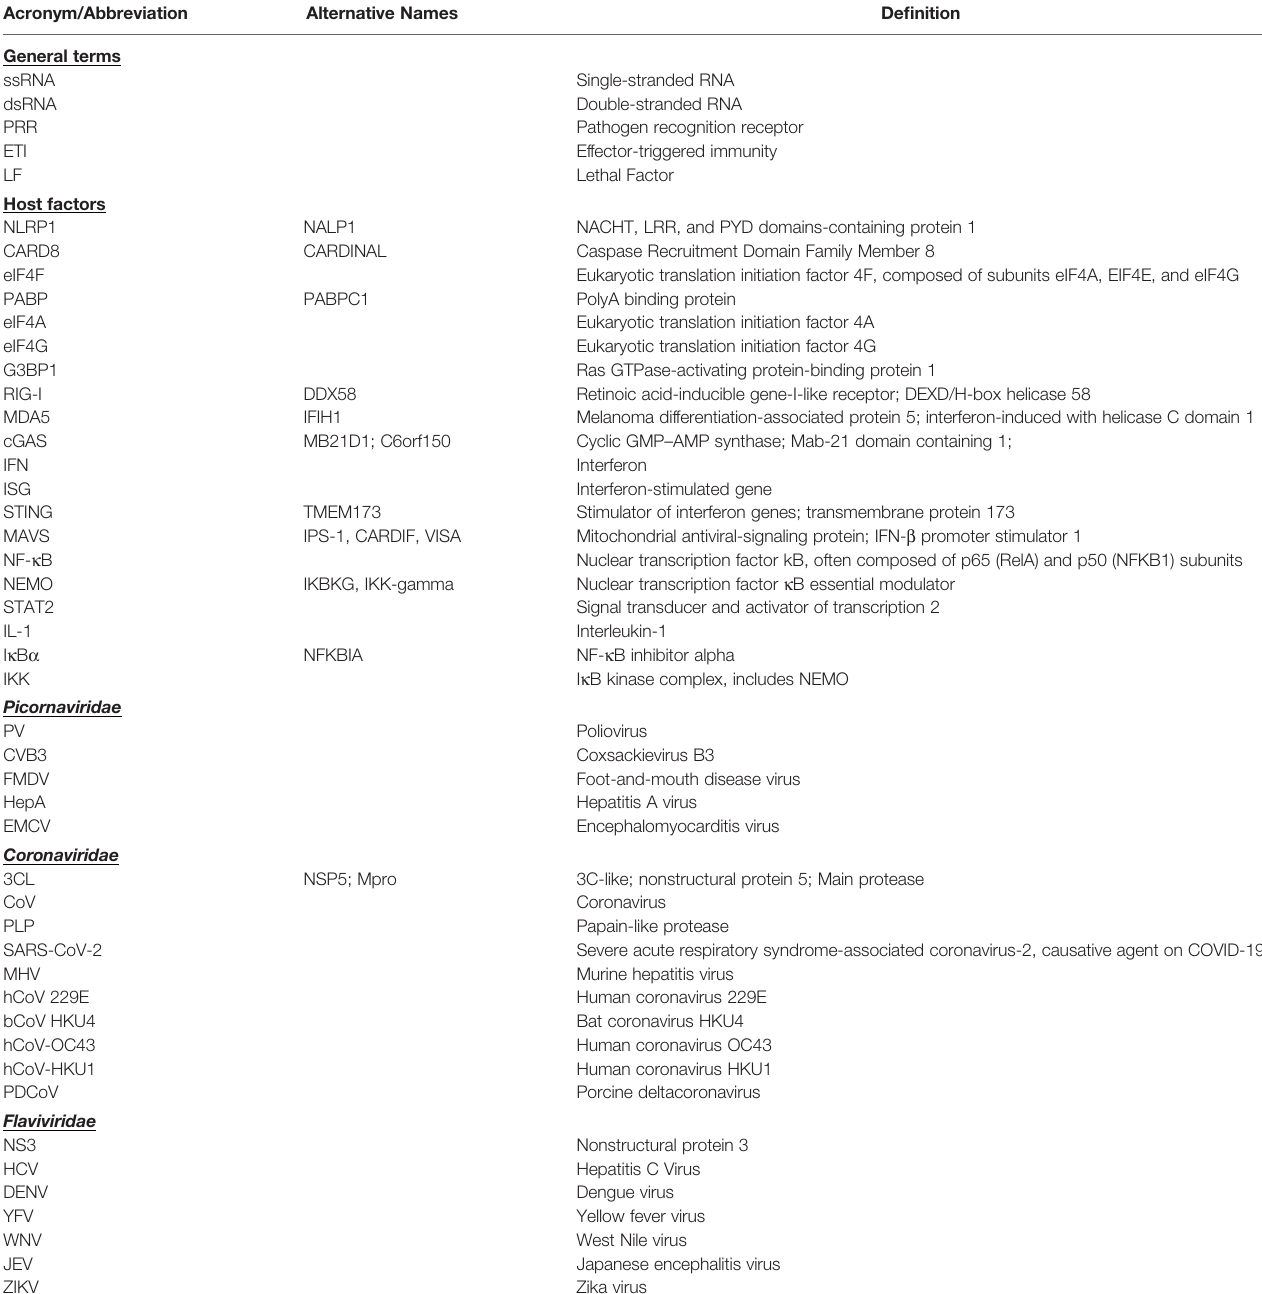
TABLE 1 | List of abbreviations and alternative names used throughout this